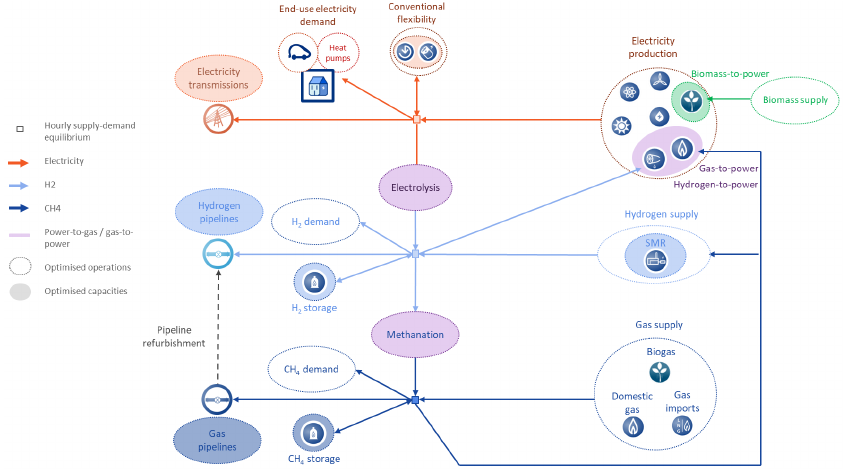
Figure 1. Schematic overview of the modelling structure of the European power, gas and hydrogen systems. H2, hydrogen; CH4, methane; SMR, steam methane